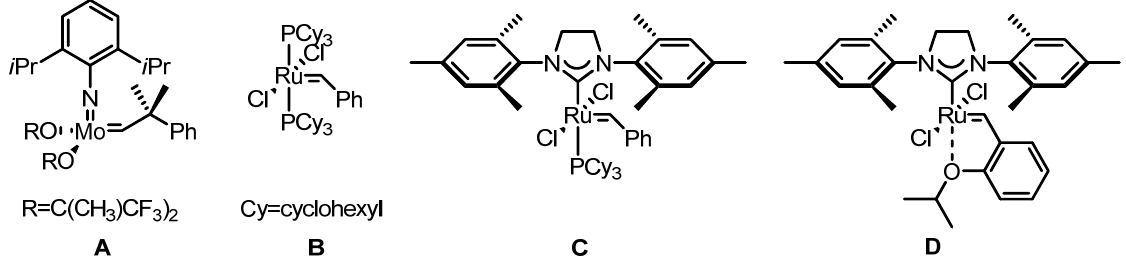
Figure 1. Representative structures of metathesis catalysts.